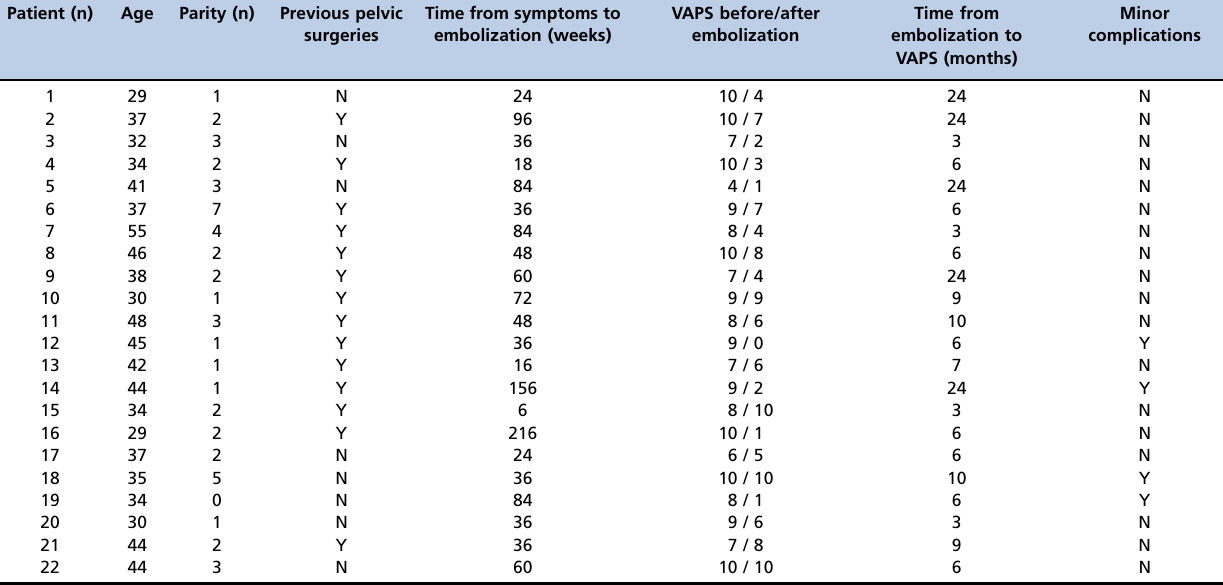
Table 1 - Individual characteristics of the patients.